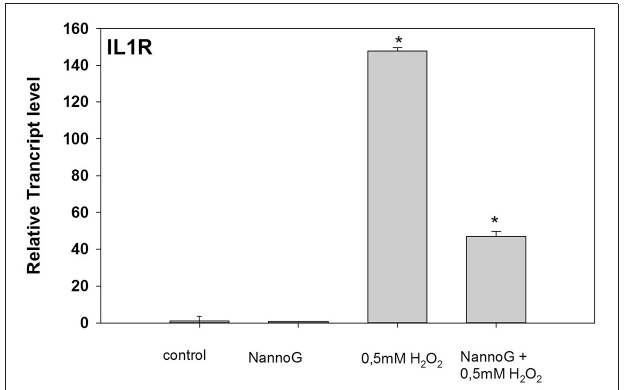
FIGURE 9 | Relative transcript accumulation of FOXO3. The experimental conditions are: cells treated with H 2 O 2 0.5 mM, pre-treated cells with NannoG (408 µ g/ml), pre-treated cells with NannoG and stressed with H 2 O 2 (0.5 mM). * p < 0.05 significantly different from all the experimental conditions.